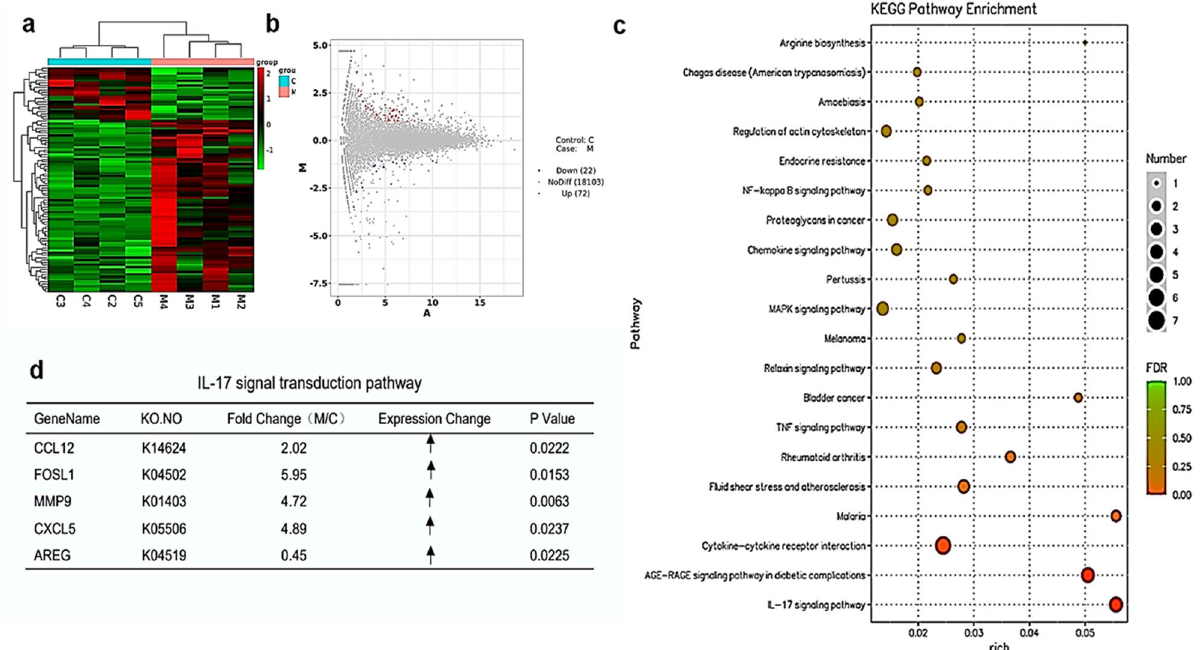
plot distribution of PM 2.5 differential genes cluster heat map in pulmonary tissues. ( c ) KEGG analysis bubble diagram of differential genes in pulmonary tissue (X-axis represents the P -value of the enrichment factor, and the Y-axis represents the names of the 12 pathways with significant differences. The size of the dots represents the number of target genes, and the color of the dots represents the range of the false discovery rate ( FDR ), which represents the ratio of target genes of a specific pathway to the number of all annotated genes in that pathway). ( d ) The 5 differential genes in pulmonary tissue were enriched into the genes table of IL-17 signal